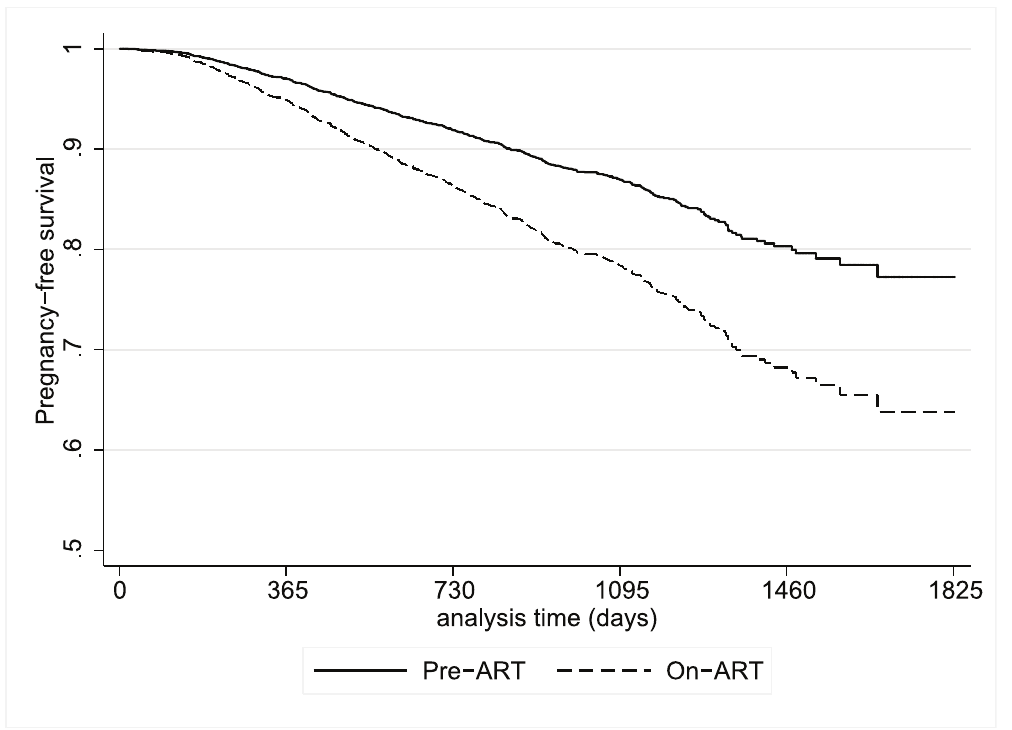
Figure 3. Plot of the postestimation pregnancy-free survival function from a proportional hazards model for participants during the pre-ART and on-ART periods. Model adjusted for participant age, education, nonbarrier contraceptive use, marital/cohabiting status, parity, enrollment of partner into the program, and current CD4 count.